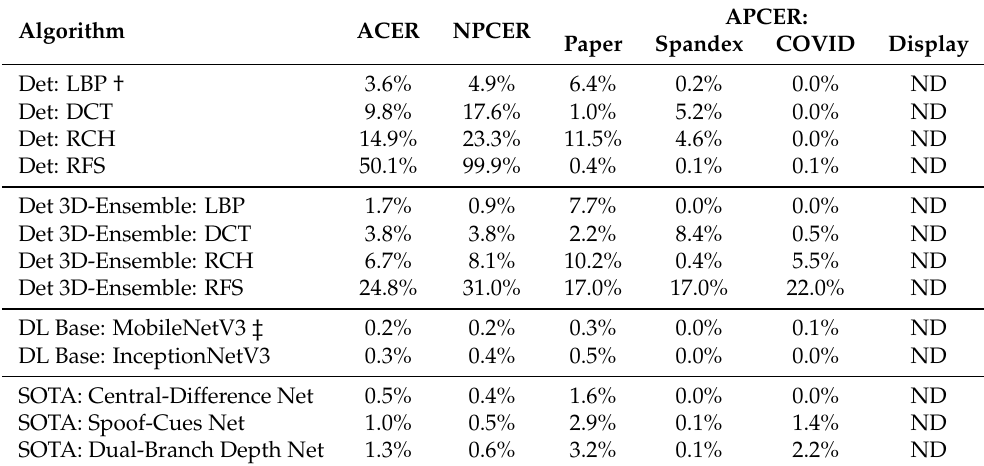
Table 2. Facial presentation–attack–detection experiment results: lab conditions. † indicates optimal deterministic algorithm. ‡ indicates optimal deep learning